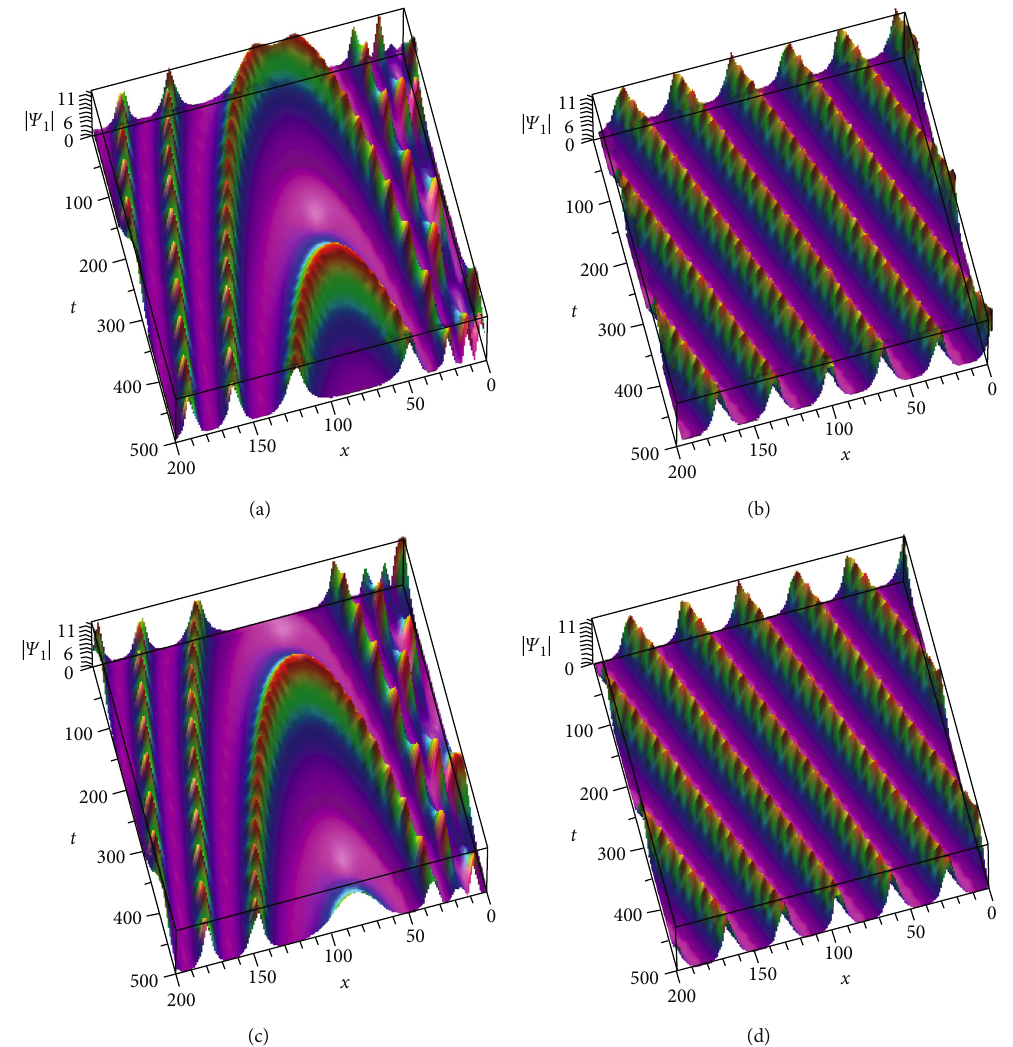
x , t Þj of Equation (26) for BFD parameter (a) μ = 0 : 9 , (b) μ = 1 and CFD parameter (c) μ = 0 : 9 and Figure 1: 3D periodic wave pro fi le j Ψ 1 ð (d) μ = 1 with other physical parameters by considering α = 2 , λ = 1 , σ = 3 , A = e , M = 0 : 2 , N = 0 : 1 , κ = 0 : 1 , Π = 2 , p 1 = r 1 = 0 : 2 , s 1 = − 0 : 3 , and θ 0 = 1